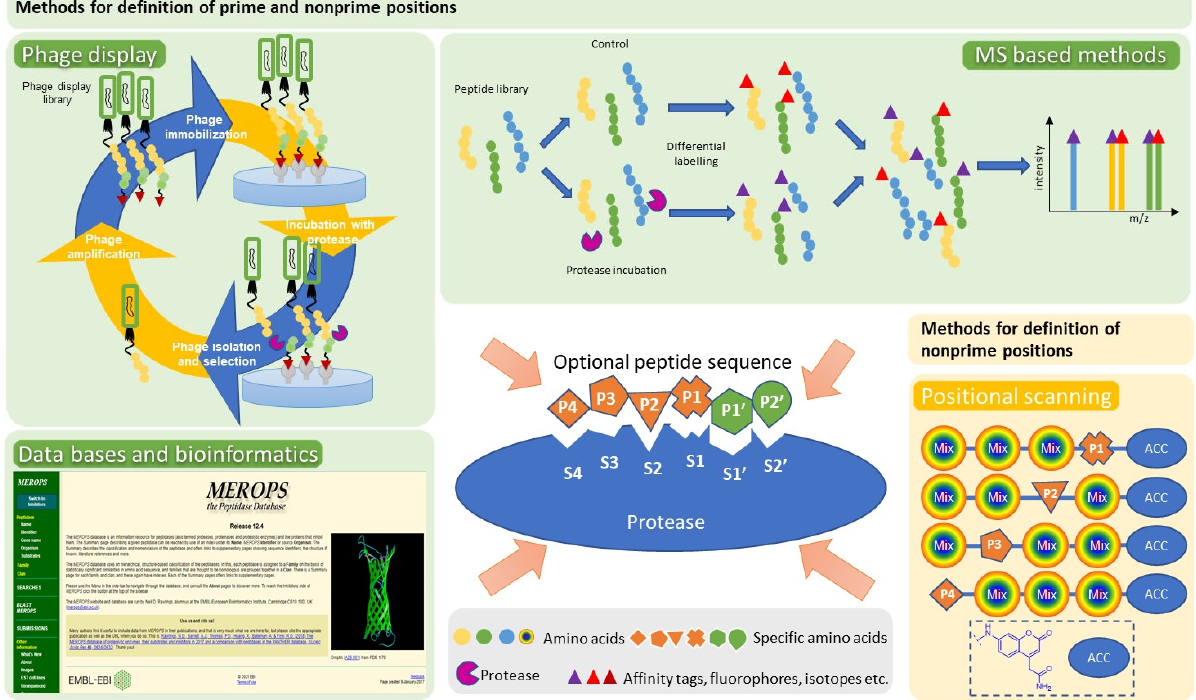
Figure 4. Methods used to map the substrate specificity of a given protease. The most frequently